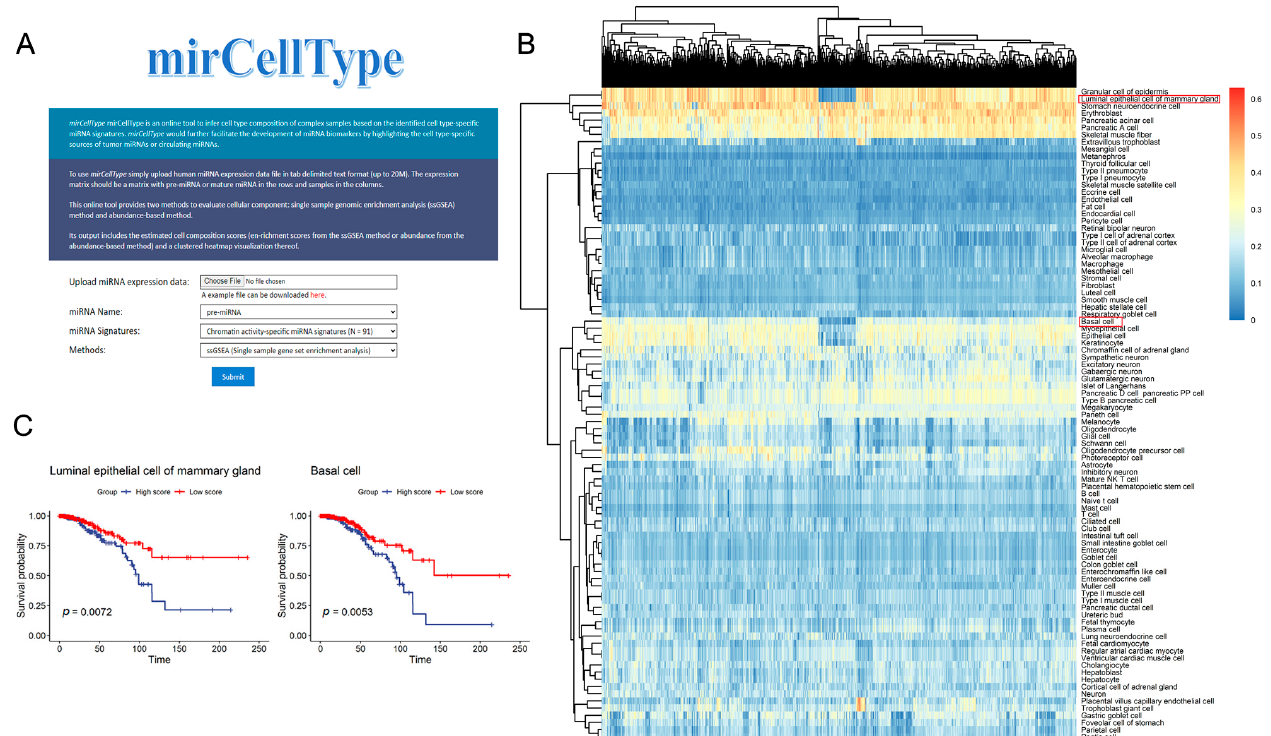
Figure 5. Overview and sample result of the mirCellType online tool. ( A ) The query interface of the mirCellType server. ( B ) Results of mirCellType analysis of BRCA miRNA expression profiles. Enrichment score results are based on cell type chromatin activity-specific miRNAs. ( C ) Kaplan–Meier survival curves showing the distinct survival between patients in the top 25% and bottom 25% enrichment score for luminal epithelial cells of the mammary gland and basal cells.